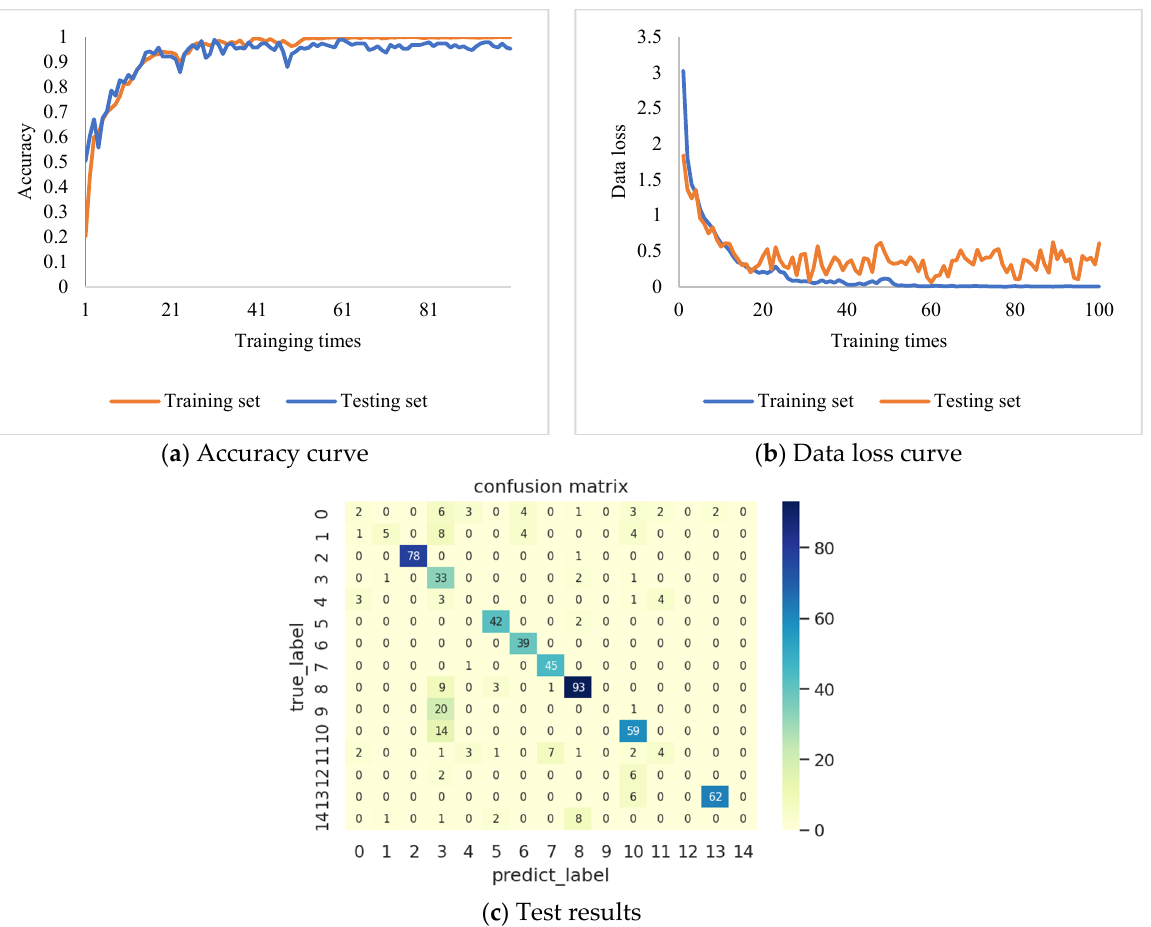
Figure 13. Transfer learning model training results based on ResNet model.